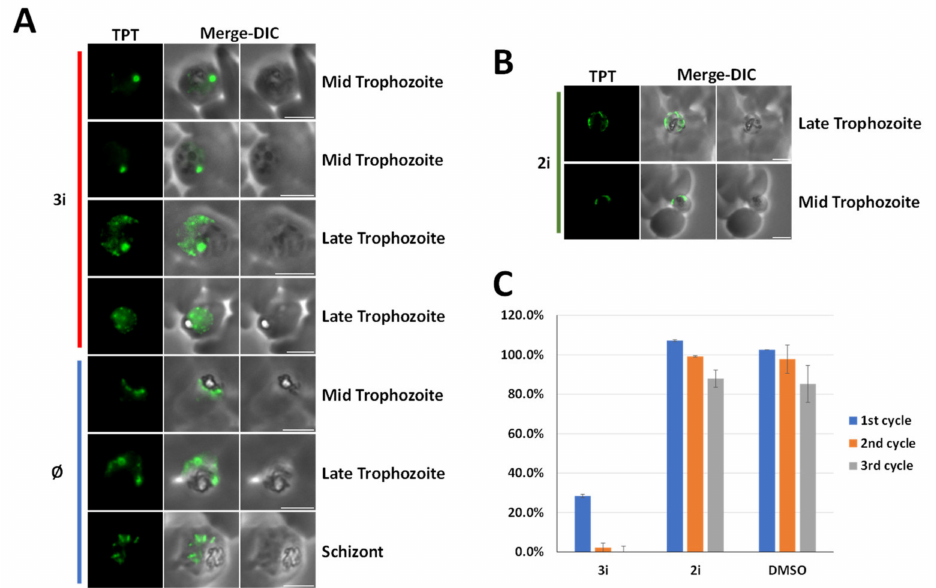
Figure 5. ( 3i ) treatment affects apicoplast biogenesis. ( A , B ) A triose phosphate transporter (TPT) fluorescent signal is shown in green (TPT labeled with an 3 × HA tag). Apicoplasts of treated parasites with 0.2 µ M of ( 3i ) molecule or 0.2 µ M of ( 2i ) are compared to normal plastid visualized in Ø untreated control. Microscopic images were obtained by a epifluorescence microscope. DIC, differential interference contrast. ( C ) Growth assay over three life cycles (48 h), bars represent the ratio treated parasites on untreated. ( n = 3, error bar = standard deviation, SD).